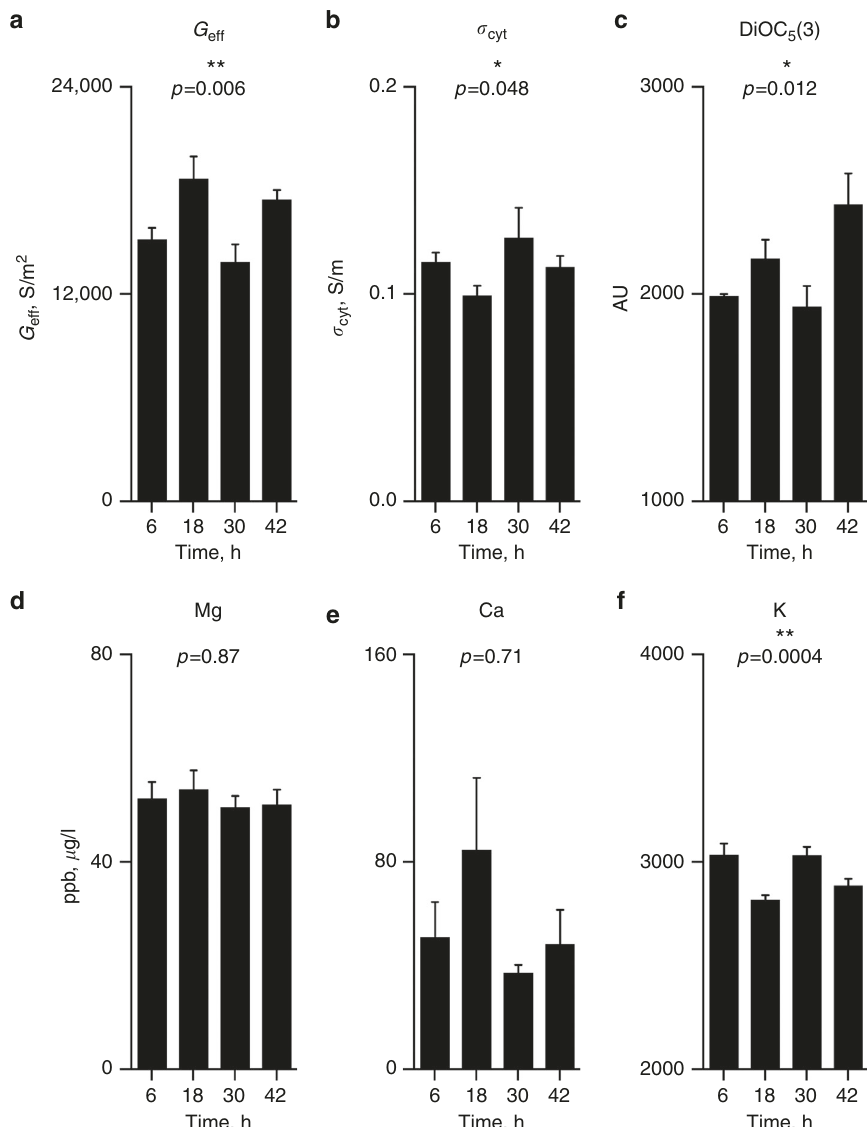
Fig. 3 Validation of circadian DEP measurements using a membrane potential sensitive dye and ICP-MS. Following synchronisation, after 18 h at constant 37 °C, G eff is signi fi cantly increased ( a ), and σ cyt signi fi cantly decreased ( b ), compared with 12 h before or afterwards, as shown in Figs 1 and 2. In RBCs sampled at these time points, we observed a signi fi cant increase in membrane potential ( c ), reported by a voltage-sensitive membrane dye (DiOC 5 (3)), and a signi fi cant decrease in cellular K content ( f ), as determined by ICP-MS. Other biologically relevant elements did not change signi fi cantly (see examples d and e , as well Supplementary Fig. 1). Note that intracellular Na + and Cl − could not be determined accurately by this method due to their high extracellular concentrations. Mean ± SEM reported throughout, n = 4 biological replicates, p values indicate Kruskal – Wallis signi fi cance